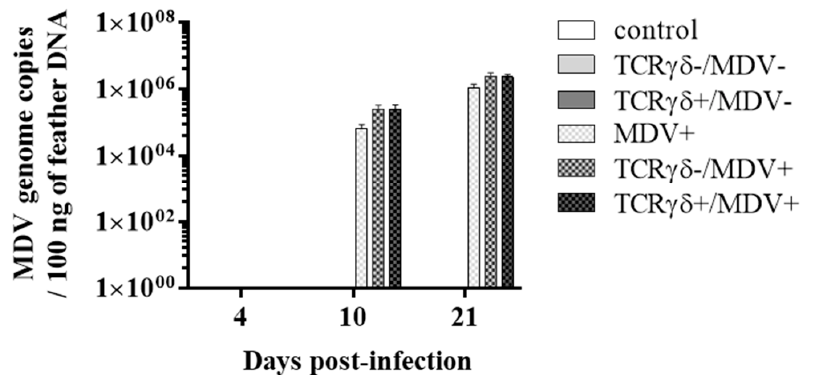
Figure 4. MDV meq gene copy number from feather tips at 4, 10, and 21 dpi. TCR γδ -activated or -unactivated PBMCs were infused to recipient chickens at 21-days-old, and the chickens were challenged with MDV. Feather samples were collected from the control, the TCR γδ -/MDV-, the TCR γδ +/MDV-, the MDV+, the TCR γδ -/MDV+, and the TCR γδ +/MDV+ groups at 4, 10, and 21 dpi. Meq gene was evaluated in 100 ng of DNA extracted from feathers. Data represent the mean of 5 biological replicates ± SE in each group at each time point.